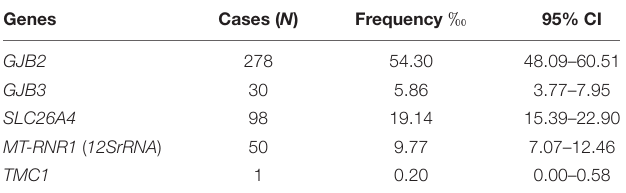
TABLE 2 | Results of genetic screening.